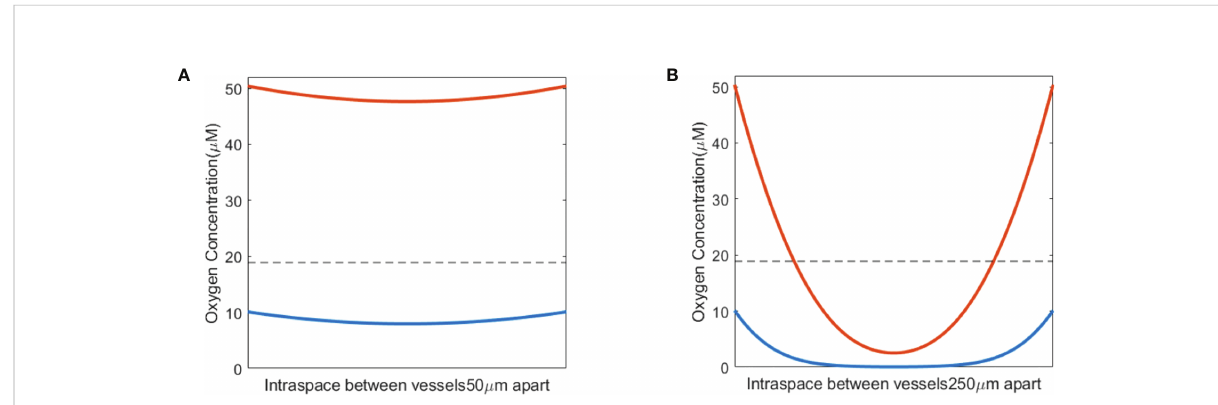
FIGURE 2 Pre-irradiation oxygen levels taking into account oxygen metabolism and diffusion. (A) Small vasculature spacing results in oxygen levels similar to vasculature oxygen BCs — normal BC of 50.4 m M (orange) or poor BC of 10.1 m M (blue). (B) Hypoxic regions develop between blood vessels in conjunction with large vasculature spacing, shown for both normal (50.4 m M; orange) and poor (10.1 m M; blue) oxygen BCs. The dashed line in panels (A, B) indicates the hypoxic threshold of 18.9 m